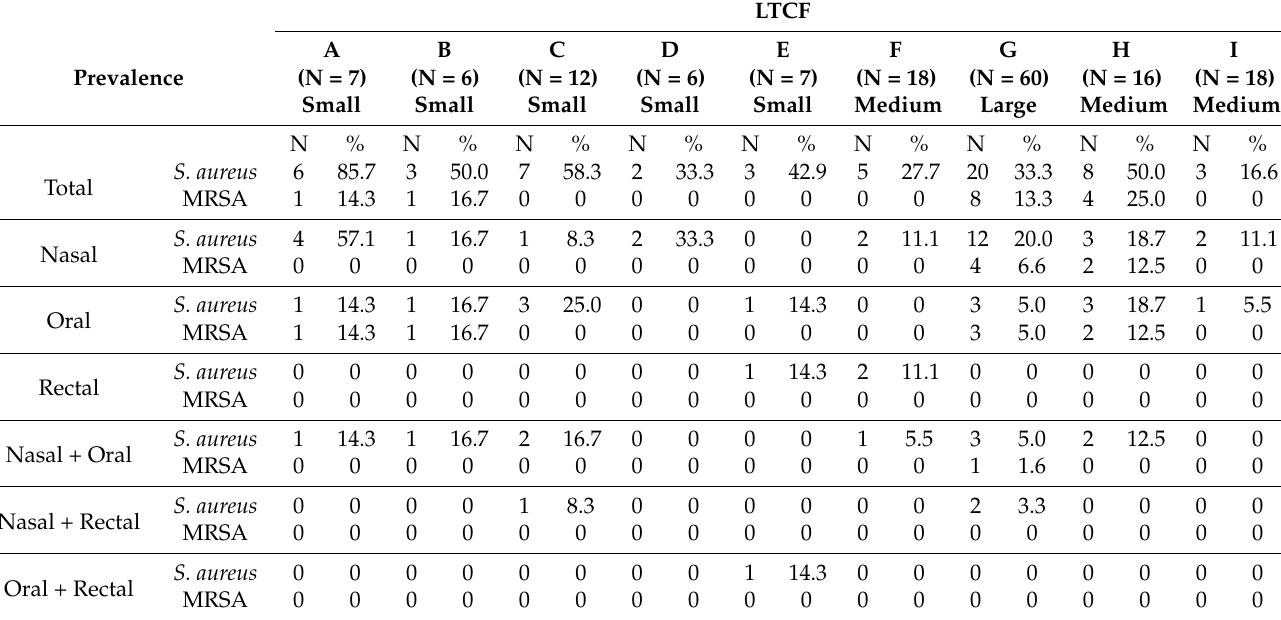
Table 1. Prevalence of S. aureus and MRSA in long-term care